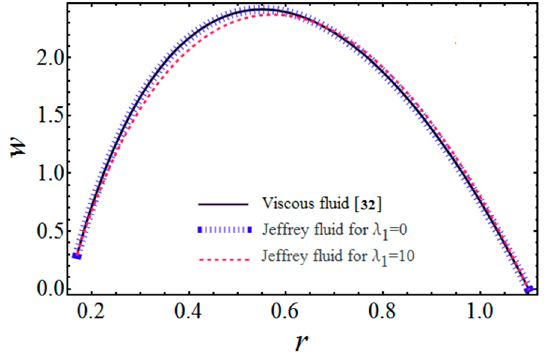
Figure 3. Residual error curves of nanoparticles’ concentration 𝜎 .